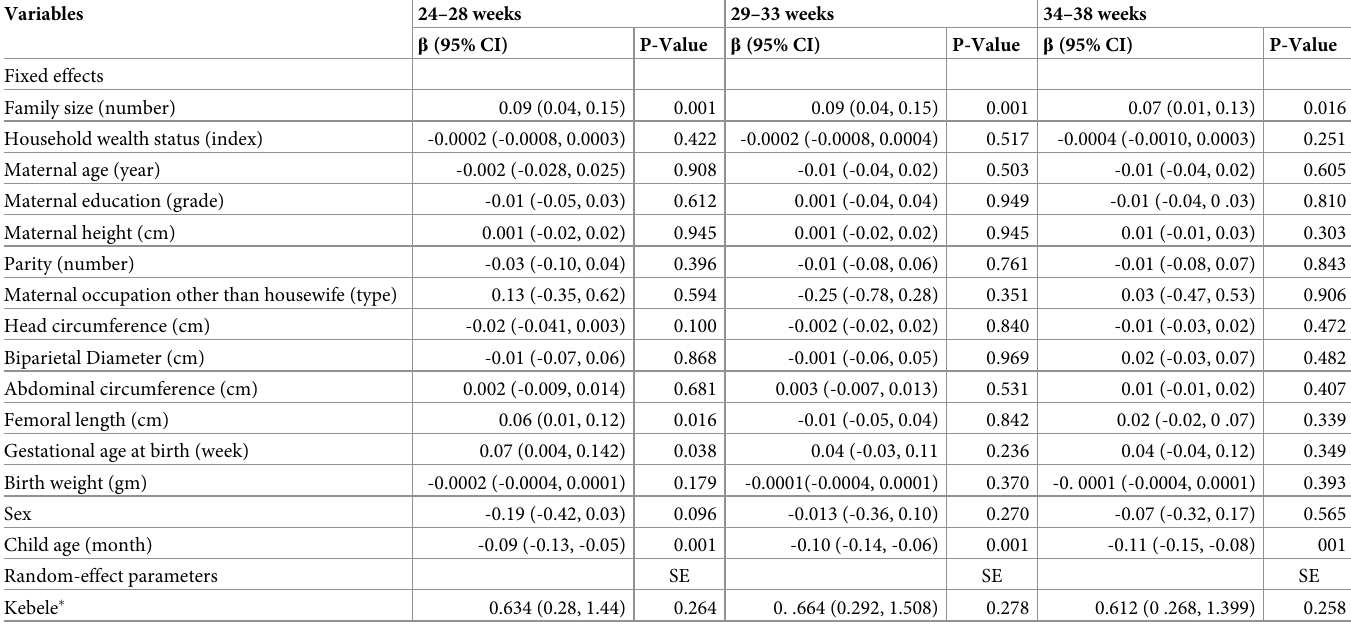
Table 5. Multilevel, mixed-effects regression coefficients for associations of household, maternal, fetal, and child characteristics with length-for-age z-score among children aged 11–24 months in Adami Tullu district, 2018.